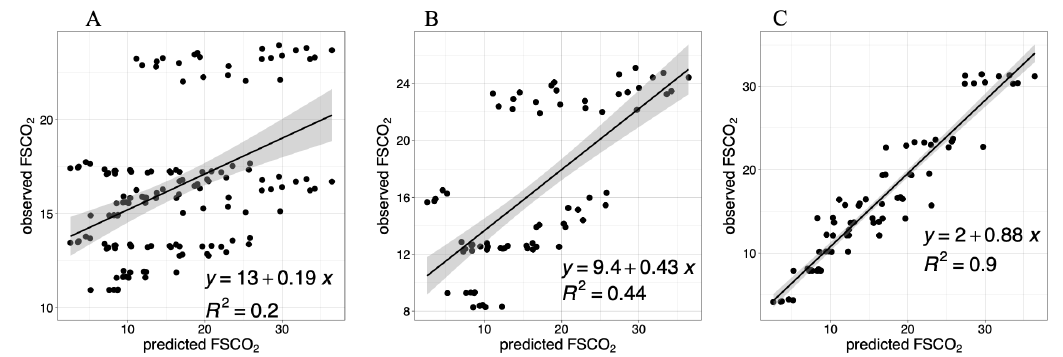
Figure 7. Predicted and estimated values of linear mixed models grouped by Month ( A ), Season ( B ) and Day ( C ) in the subtropical forest region.